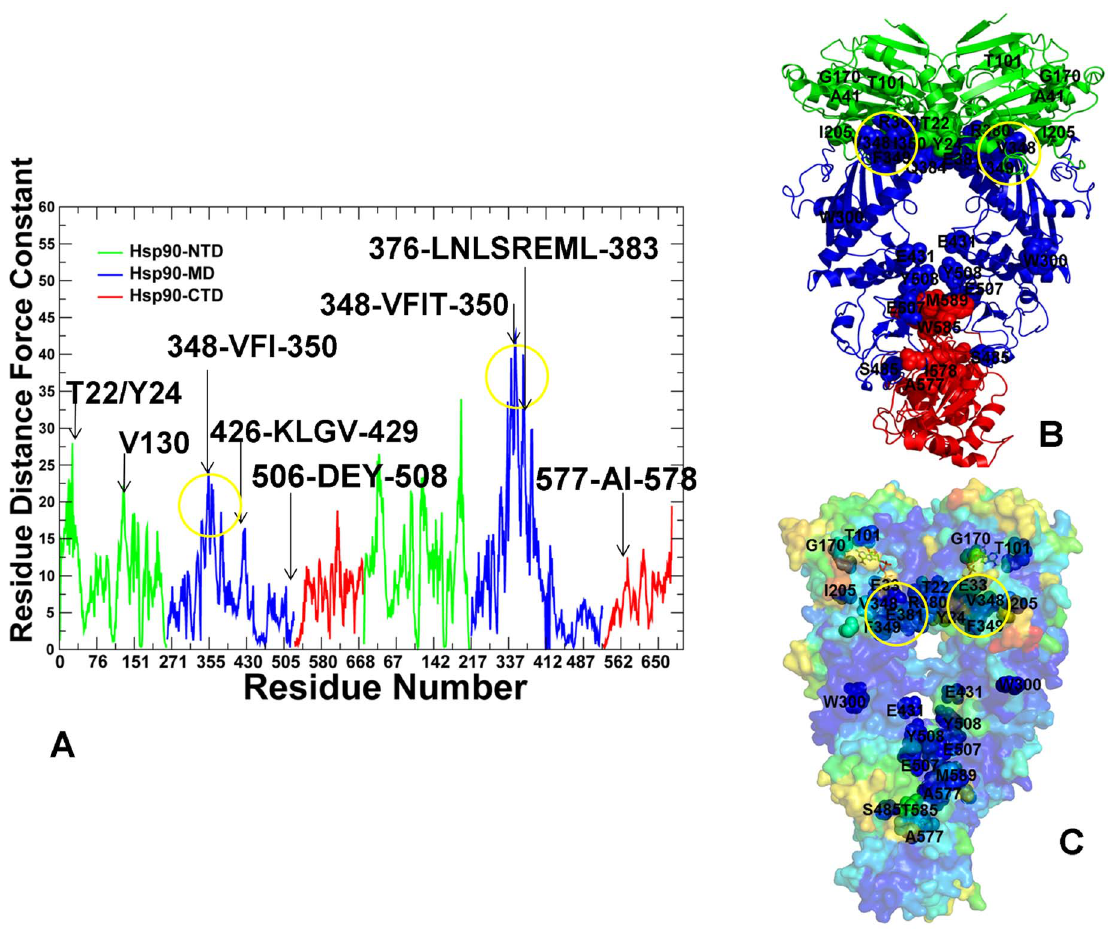
Figure 6. The Force Constant Stability Analysis of the ATP-bound yeast Hsp90 Chaperone. (A) The residue-based force constant profile of the ATP-bound yeast Hsp90 structure. The NTD residues are in green, MD residues are in blue, and CTD residues are in red. The residue-based dynamic profiles are annotated using the residue numbering in the original crystal structure [55]. The peaks of the force constant profiles corresponding to functionally important residues are indicated by arrows and annotated. Functional residues corresponding to the peaks in the force constant distribution are mapped onto the domain-colored crystal structure of the ATP-bound yeast Hsp90 (B) and onto the functional dynamics profile of the ATP-bound yeast Hsp90 (C). Functional residues are annotated and shown in spheres and colored as in Figure